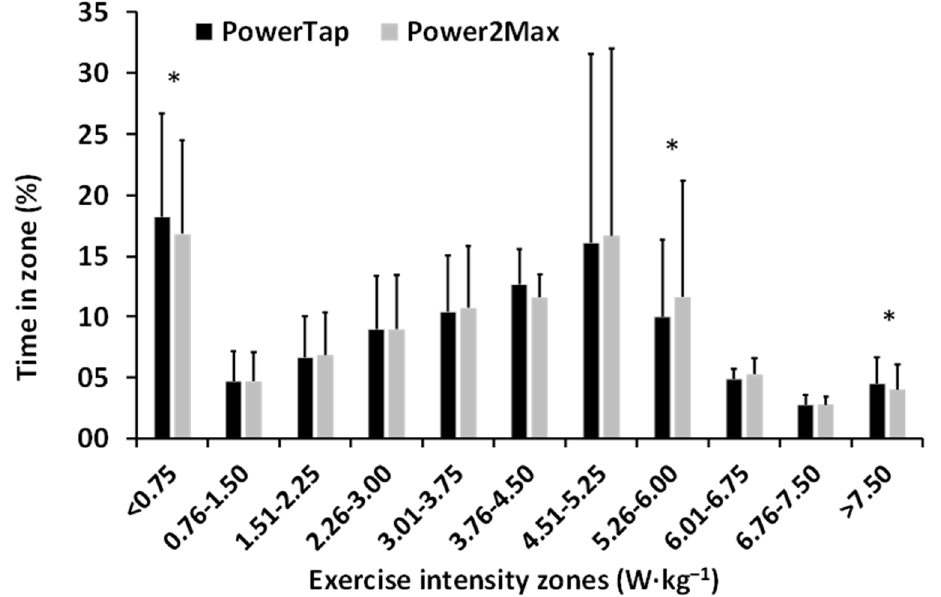
Figure 1. Mean ± SD of the time spent in each exercise intensity zone during the six official cycling competitions registered by the PowerTap and Power2Max power meters. * = significant differences ( p < 0.05) between both power meters.